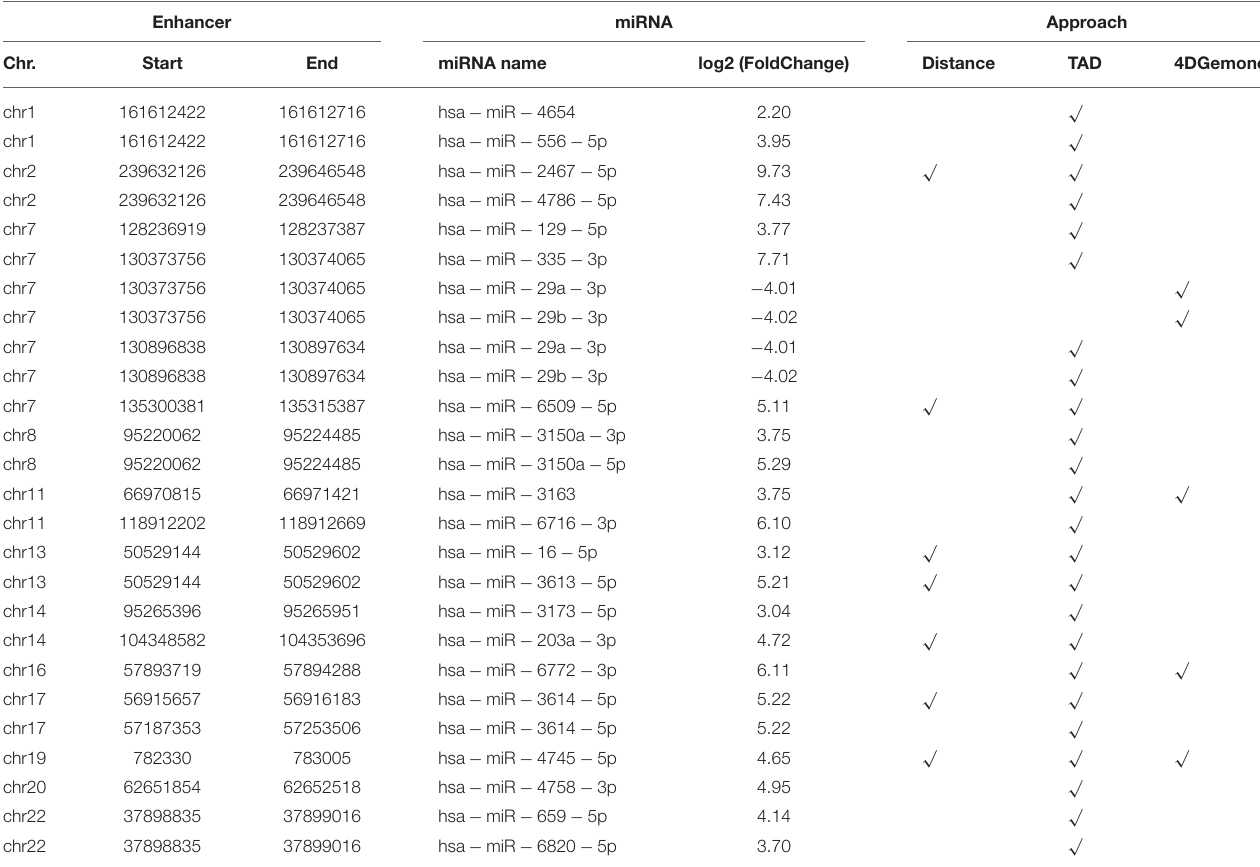
TABLE 1 | 26 Enh p53 -regulated miRNA identified by the integration of three approaches. Enhancer miRNA Approach